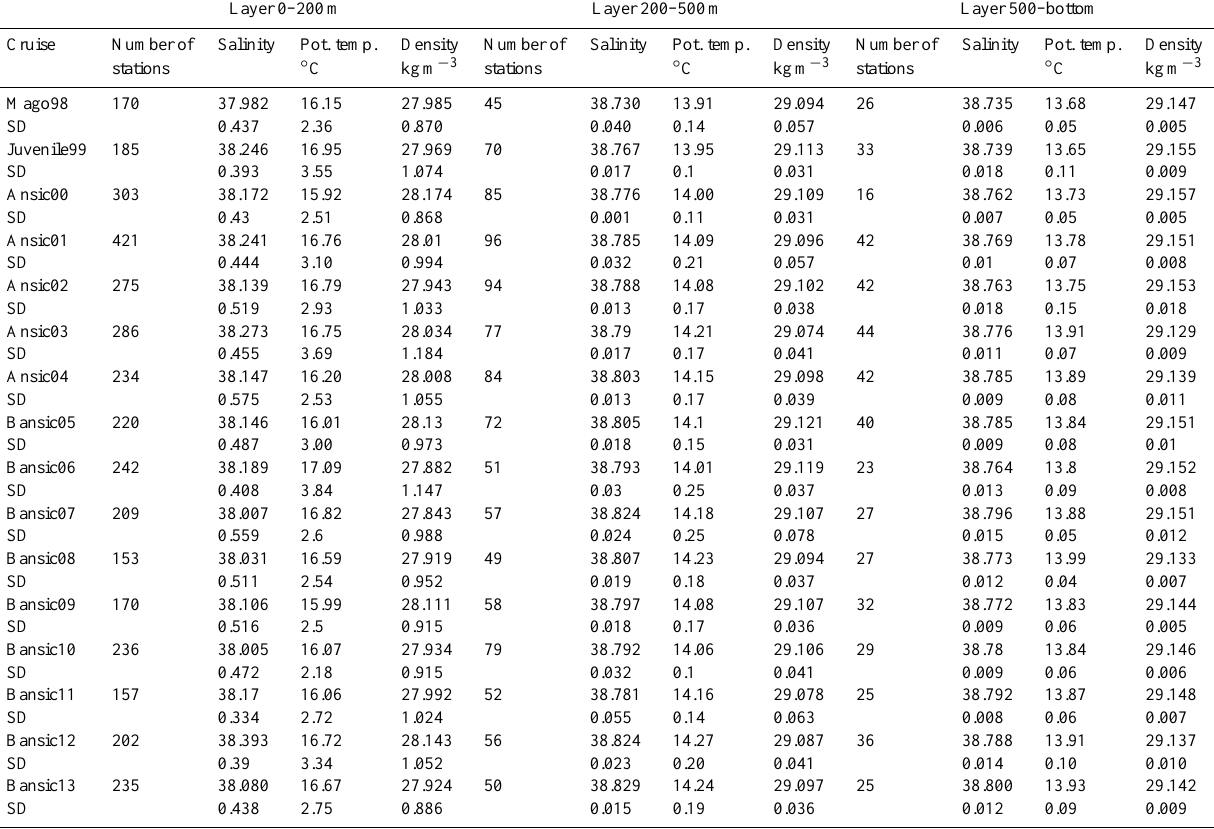
Table 2. Number of stations for each layer and average values and standard deviations (SDs) of salinity, potential temperature ( ◦ C) and potential density (kgm − 3 ) for each survey. In the layer 0–200m are also included transitional waters.